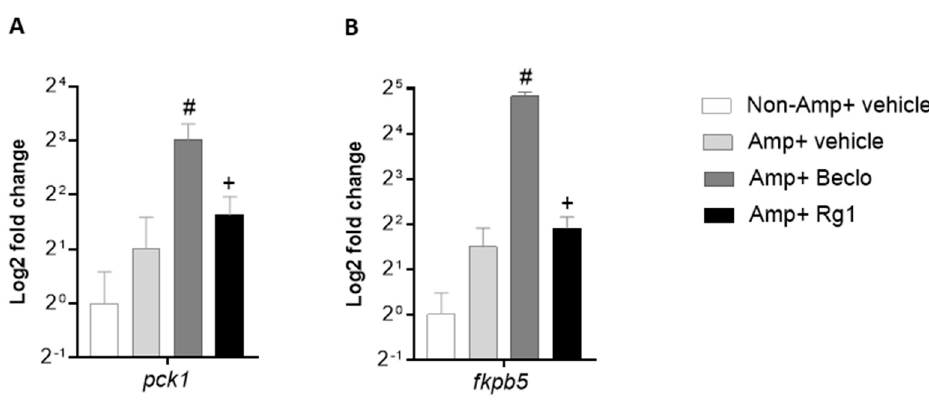
Figure 4. Differential effects of Rg1 and beclomethasone on the expression of endogenous Gr target genes. Expression analysis by qPCR using total RNA from 3 dpf larvae with (Amp) or without (Non-Amp) amputation and treated with vehicle, beclomethasone (Beclo), or Rg1. ( A ) Gene encoding Phosphoenolpyruvate Carboxykinase (Pck1). ( B ) Gene encoding FK506 binding protein 5 (Fkbp5). The relative expression values were normalized to those of ppial and are shown on a log2 scale. Bars represent the mean ± SEM of three independent experiments (each with technical duplicates). # p < 0.01 compared with the amputated vehicle group. + p < 0.05 compared with the amputated Beclo group.